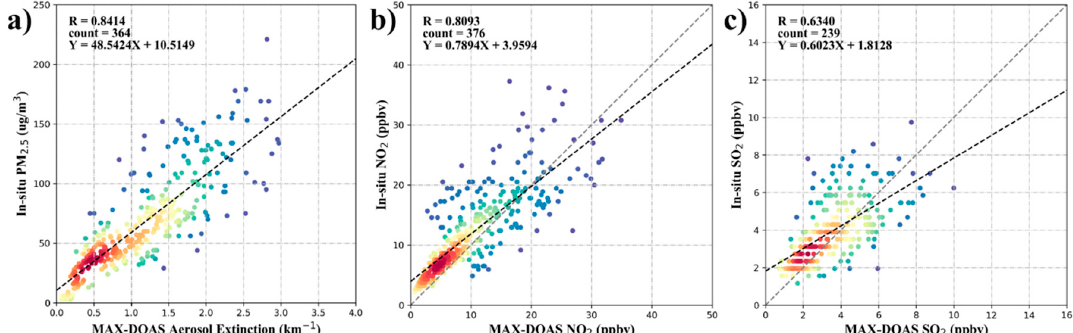
Figure A1. Comparison results for near-surface layer between MAX-DOAS profiles and CNEMC data: ( a ) aerosol extinction; ( b ) NO 2 ; ( c ) SO 2 (colors represent data points’ densities; warmer colors represent more data points).